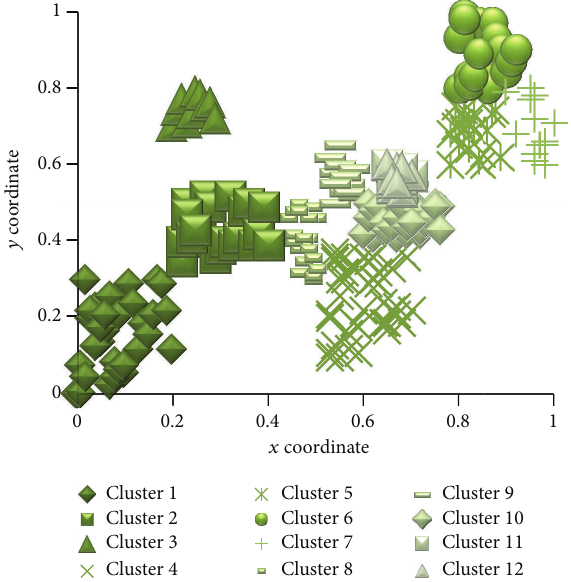
Figure 4: Clusters of agents obtained after applying cluster-creation algorithm.